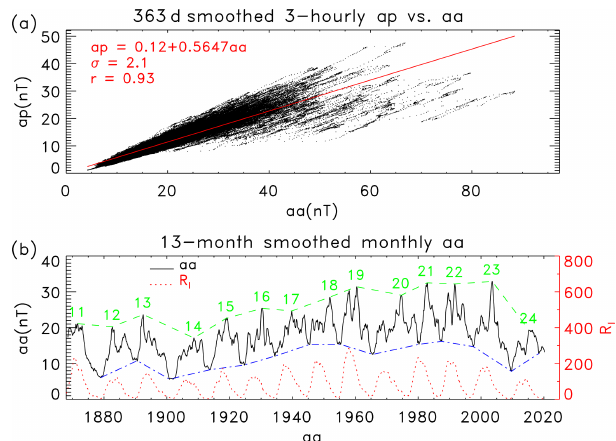
Figure 5. (a) Scatter plot of the 363d smoothed 3-hourly ap against aa (dots) and the linear fit (solid). (b) The 13-month smoothed monthly mean aa (solid) and R I (dotted). The numbers in the figure indicate the solar cycles. The upper dashed and lower dashed–dotted lines indicate the maximum ( aa max ) and minimum ( aa min ) of aa , respectively, for the solar cycle.